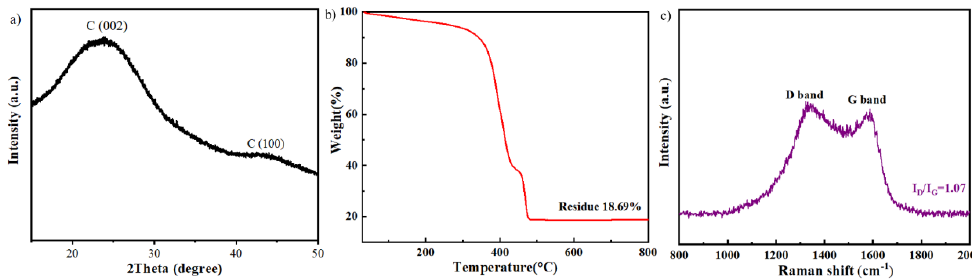
Figure 7. ( a ) XRD pattern of the Co–ZIF–8 catalyst; ( b ) TGA curve of the Co–ZIF–8 catalyst; ( c ) Raman spectrum of the Co–ZIF–8 catalyst.